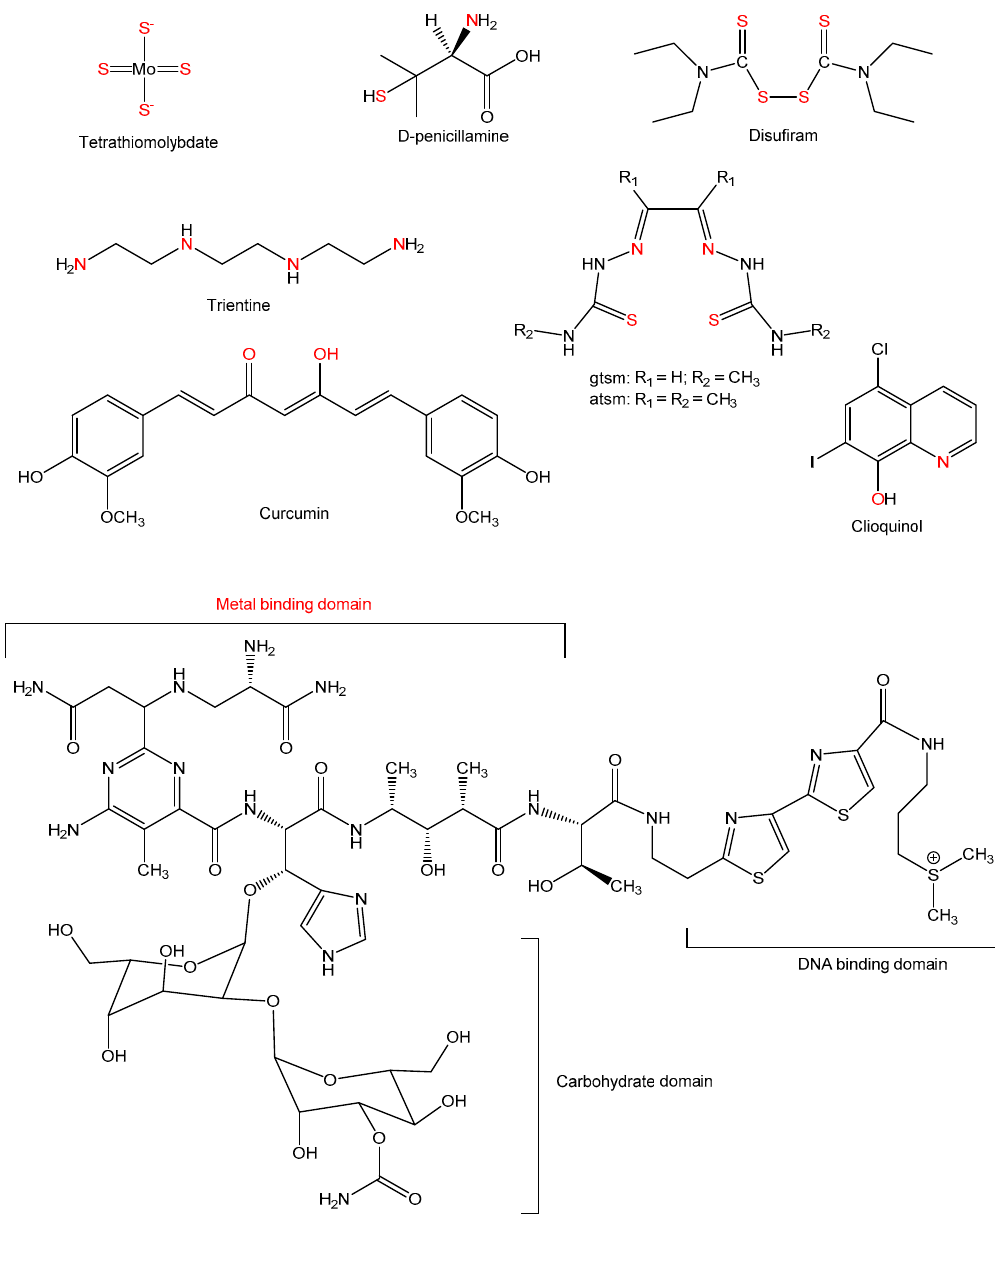
Figure 2. The structure of select Cu chelators for potential anticancer applications.